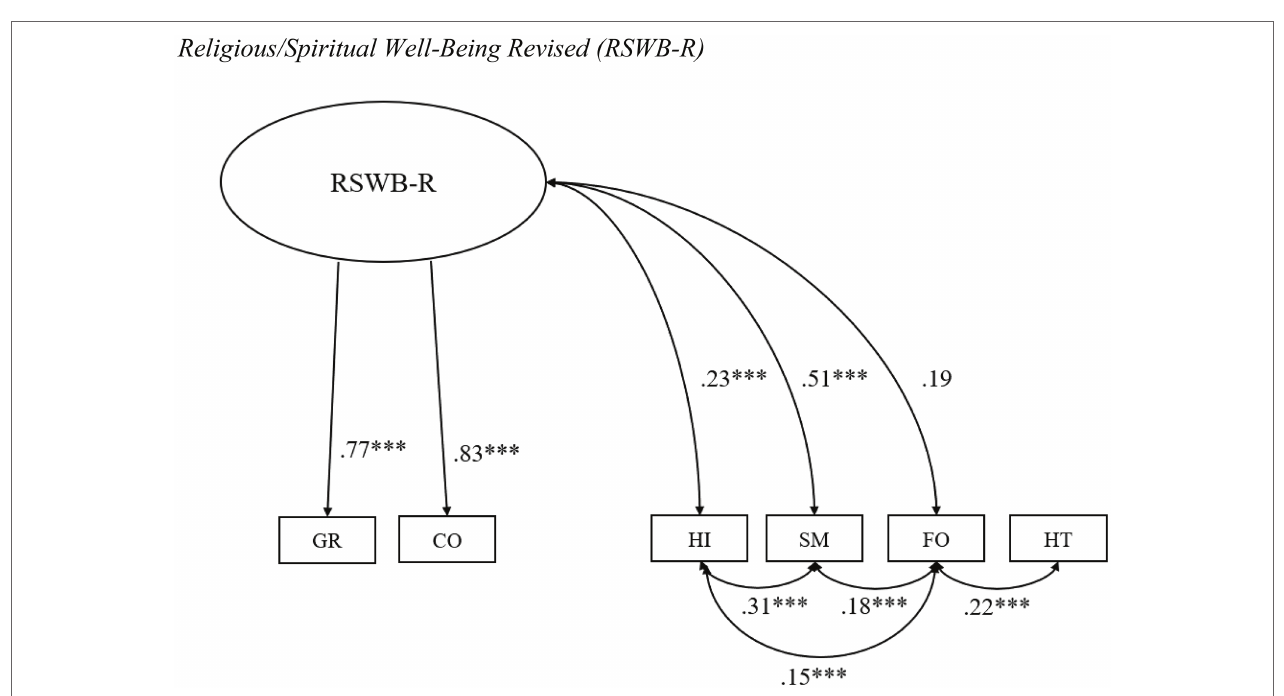
FIGURE 2 | Religious/Spiritual Well-Being Revised (RSWB-R). Confirmatory factor analysis ( n = 711). GR, General Religiosity; CO, Connectedness; HI, Hope Immanent; SM, Experiences of Sense and Meaning; FO, Forgiveness; HT, Hope Transcendent; and RSWB-R, Religious/Spiritual Well-Being Revised. *** p < 0.001.